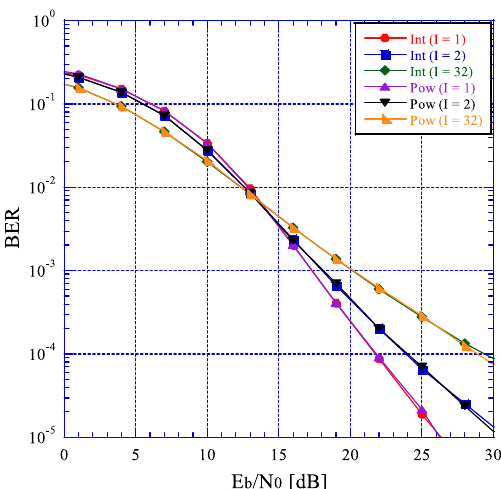
Fig. 8 BER of the various E b / N 0 for the interleaved block subcarrier allocation and the power combination with the DFT and the ZF, without the coding